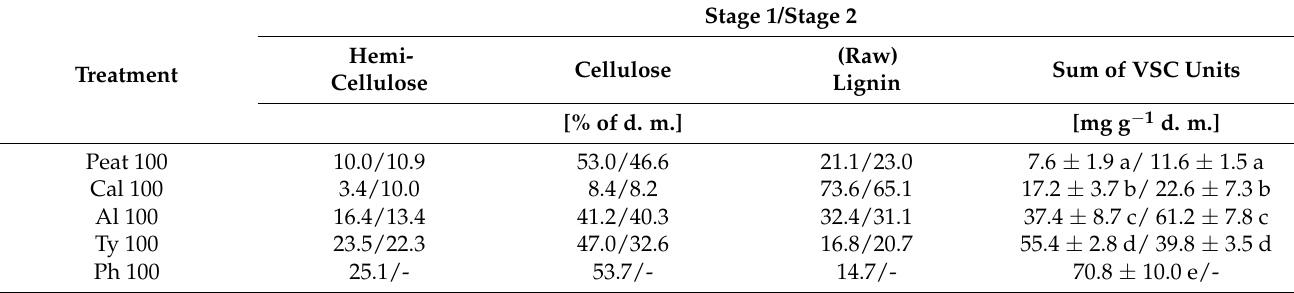
Table 7. Proportions of cellulose, hemicellulose, and raw lignin (n = 1) and sum of VSC units (n = 4) of each processed raw material in stage 1 and stage 2. VSC units: variance analysis: ANOVA, post hoc test: pairwise t test, p < 0.05. d.m.: dry matter. Different letters indicate significant differences among treatments. Explanation of treatment names see Table 1.